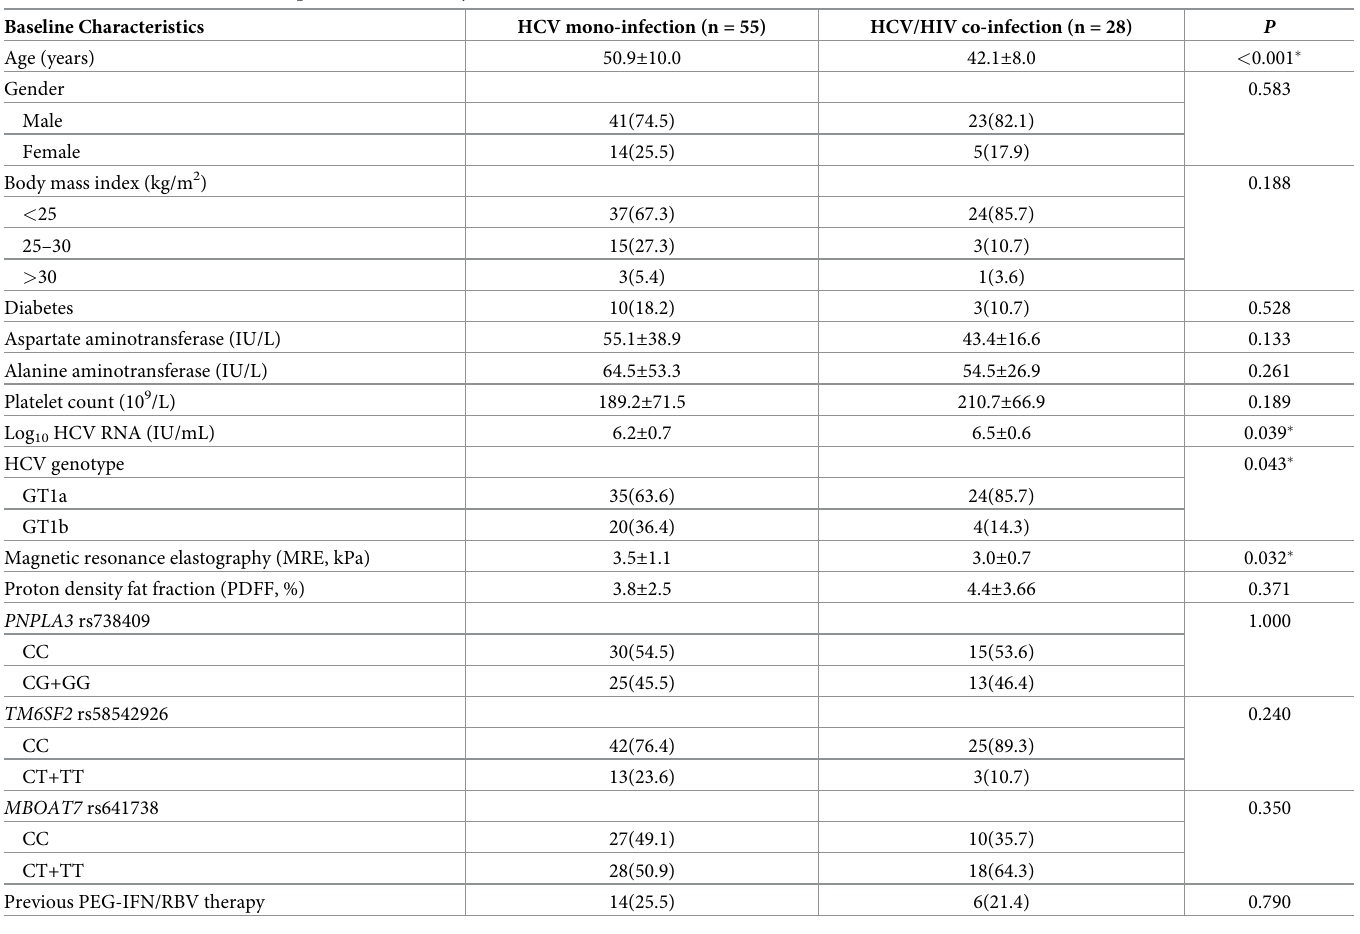
Table 1. Baseline characteristics of patients in this study.